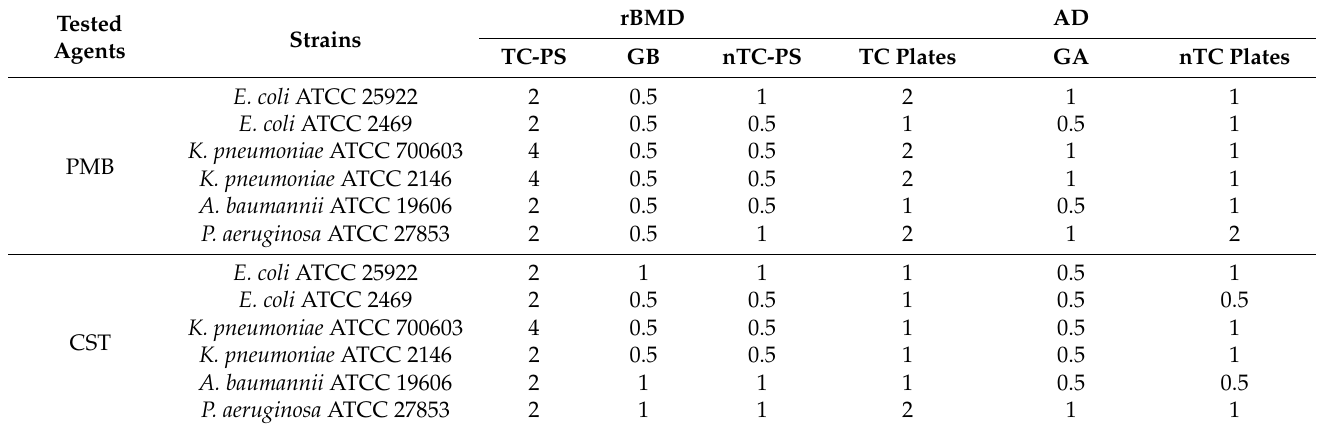
Table 4. Differences of MICs of polymyxin B and colistin on different plate